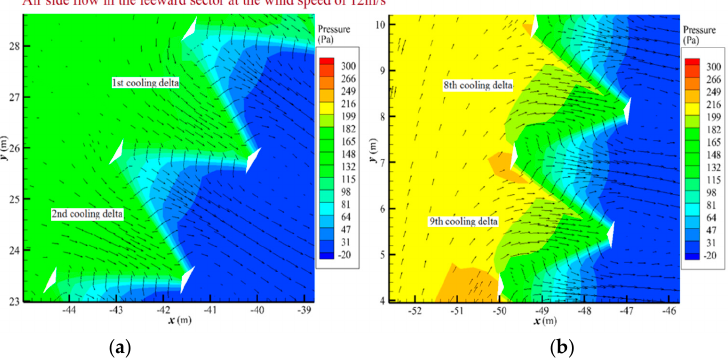
Figure 8. Air flows of representing deltas in rear sector under a crosswind of 12 m/s, ( a ) 1st and 2nd delta in leeward section; ( b ) 8th and 9th delta in leeward